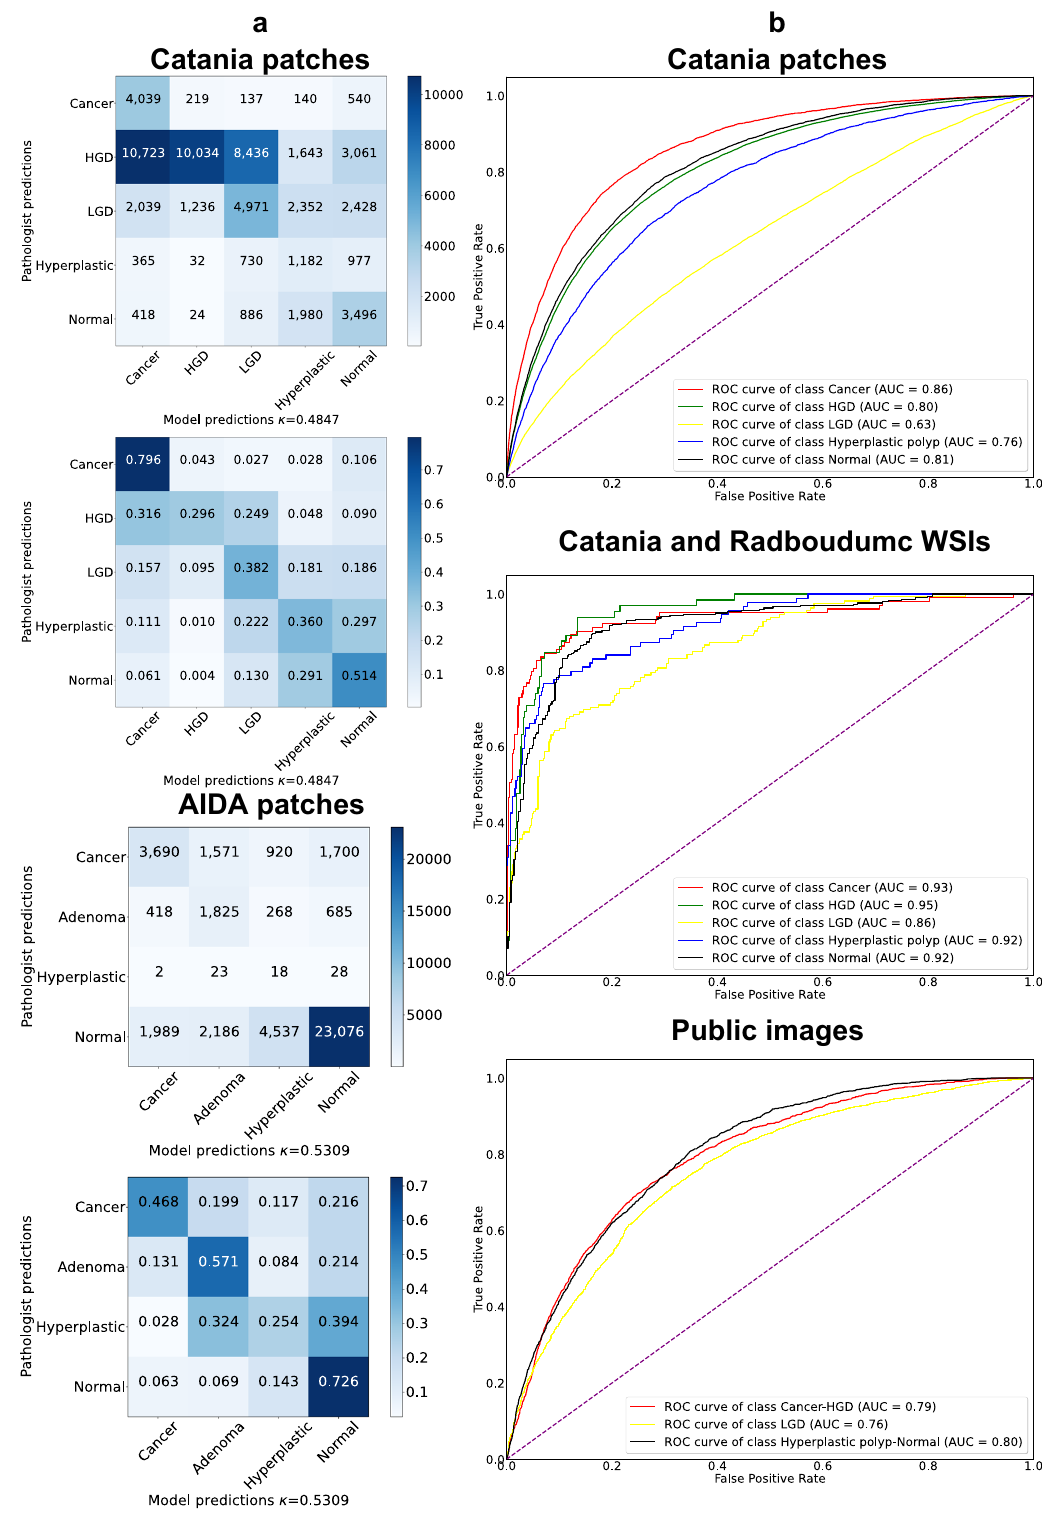
Fig. 2 Quantitative evaluation of the classi fi cation models at patch- and WSI-level. a Confusion matrices of the CNN models that reach the highest performance in the patch-level classi fi cation. The matrices include the raw and the normalized values. The matrices are reported for Catania (upper part) and AIDA (lower part). The AIDA dataset includes a class called dysplasia, instead of high-grade and low-grade dysplasia. The ground truth and the predictions are mapped into the dysplasia class. b ROC curves of the CNN models for the patch-level classi fi cation (Catania), the WSI-level classi fi cation (Catania) and the image-level classi fi cation (publicly available data). In the latter sub-Figure, the predictions are aggregated to match the different annotations across publicly available